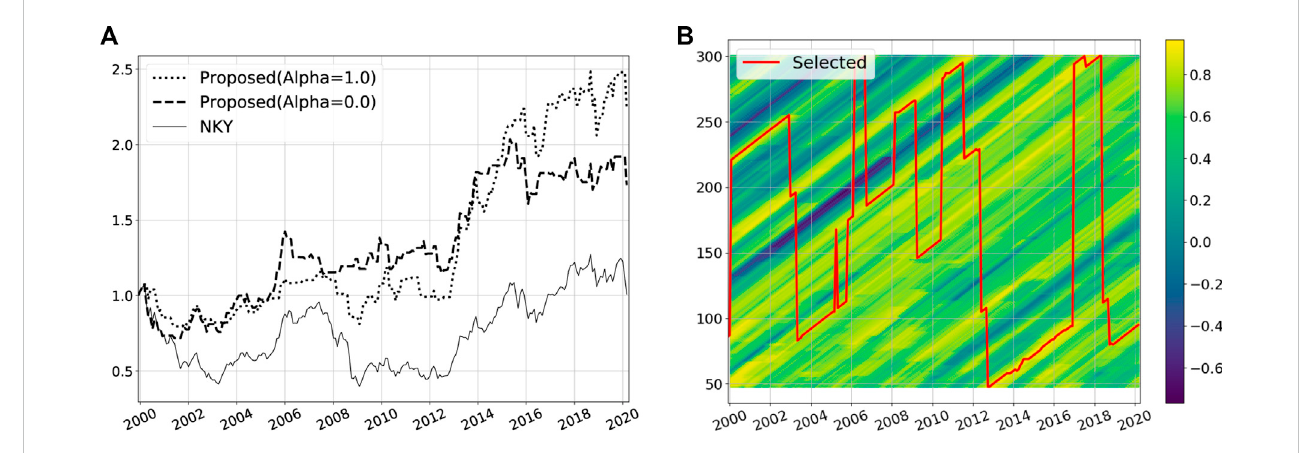
FIGURE 4 Investment results (A) and attention (B) of